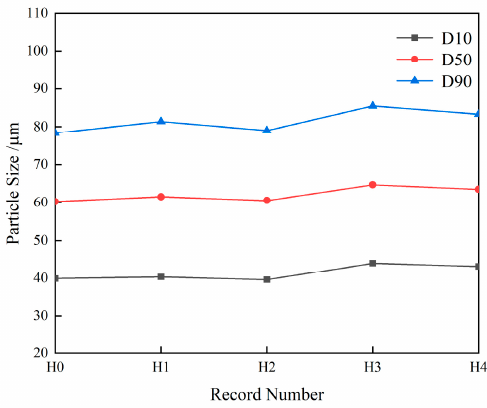
Figure 5. D values of particles.